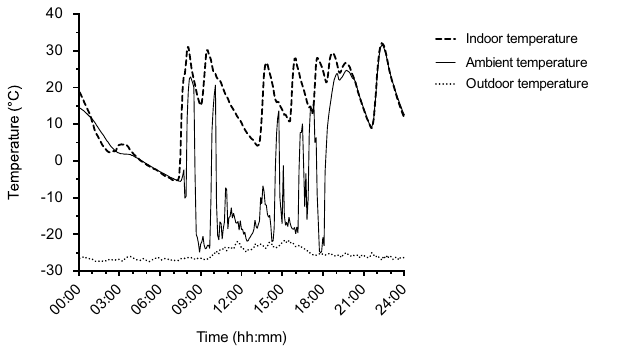
Figure 1. Example 24-h profiles of environmental temperatures. Indoor temperature was measured inside a yurt. Outdoor temperature was measured outside the same yurt. A participant’s (male, 58 years) ambient temperature was measured with a temperature sensor attached to the outer surface of their clothing. Sampling rate was 5